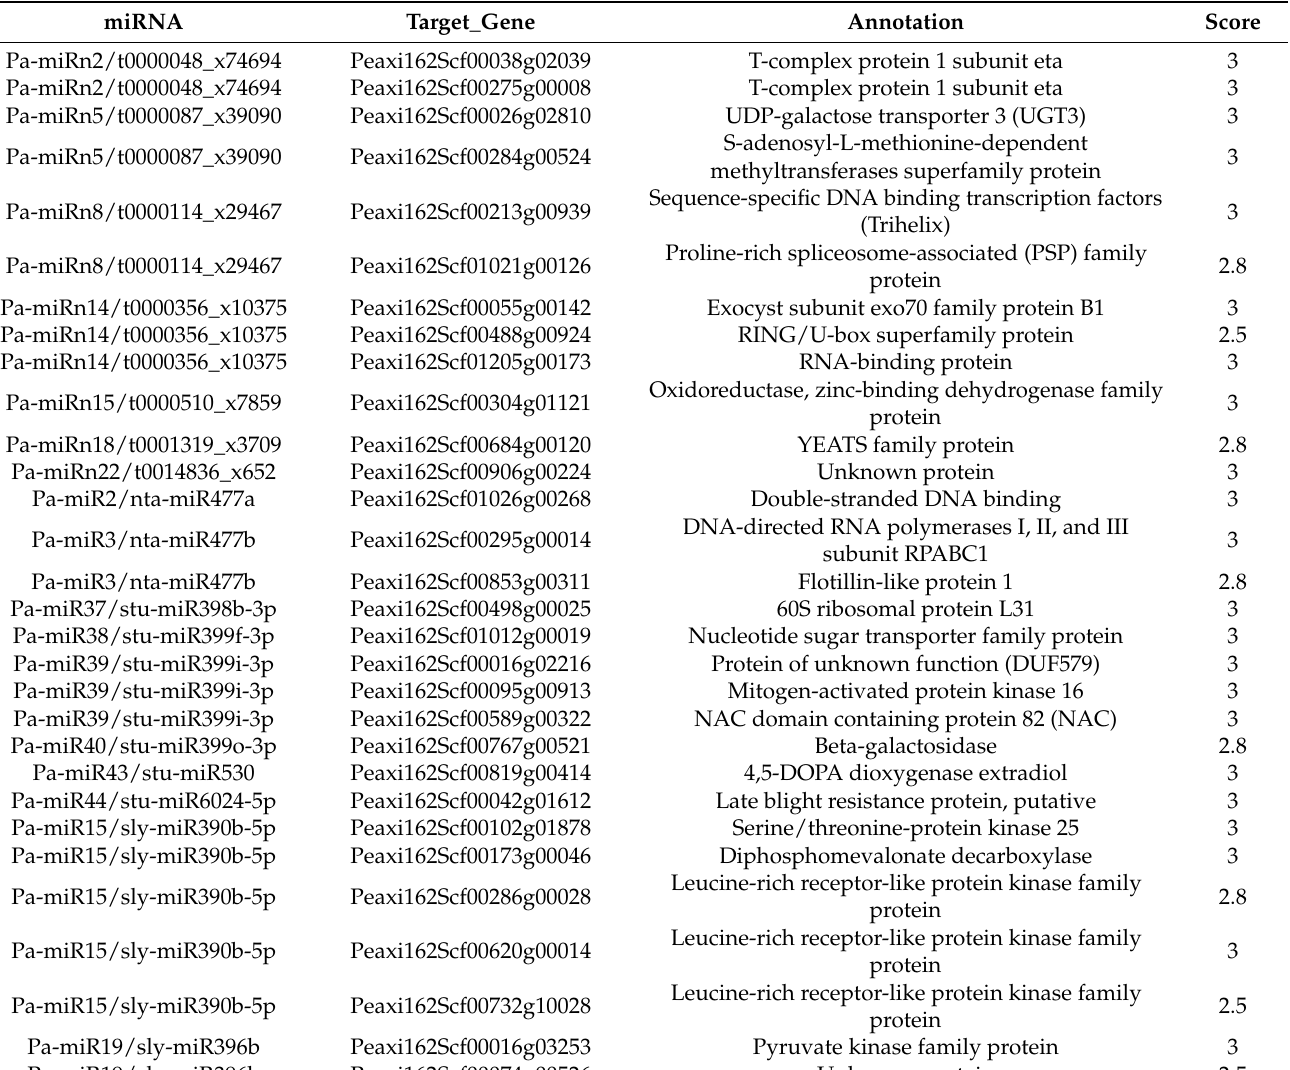
Table 2. The correlation analysis of miRNA and its target